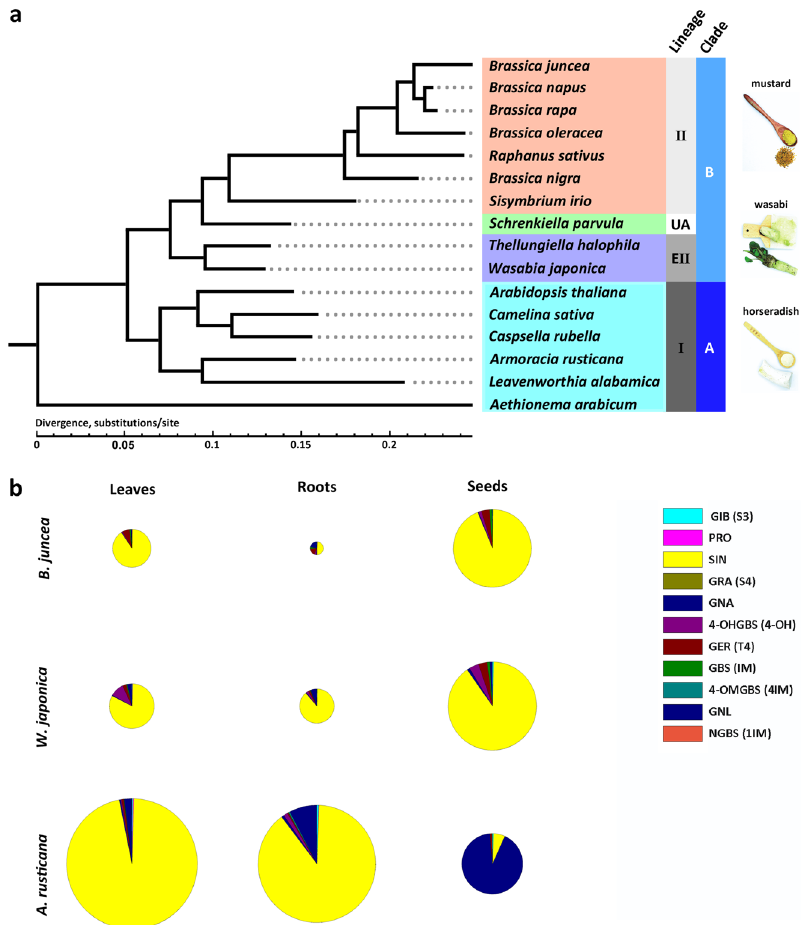
Fig. 1 GSL components in the leaves, roots and seeds of W . japonica , A . rusticana and B . juncea . a Phylogenetic tree of Brassicaceae and three species with wasabi qualities (mustard, B. juncea ; wasabi, W. japonica ; and horseradish, A. rusticana ). I, II and EII indicate Lineage I, II, and Expanded Lineage II, respectively. A and B refer to clades. b GSL components in the leaves, roots, and seeds of B. juncea , W . japonica , and A . rusticana